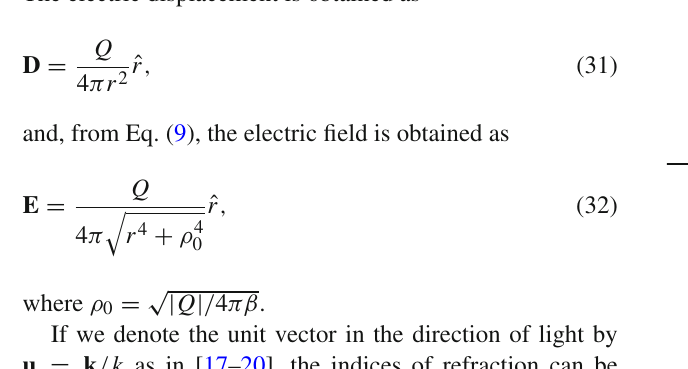
Fig. 1 Schematic of light bending in a Coulombic field